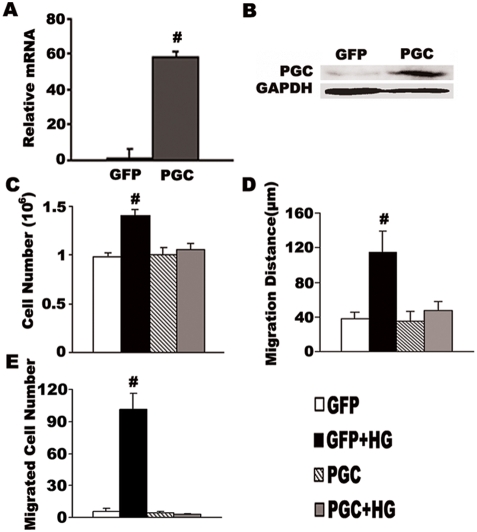
Overexpression of PGC-1α suppresses high glucose induced VSMC proliferation and migration.Cultured rat VSMCs in 5.5 mM glucose infected with adenovirus driving the expression of PGC-1α (PGC group) or GFP (GFP group) were either left untreated or incubated with 15 mM gluoose (HG) for 48 h. PGC-1α mRNA expression was determined by real-time RT-PCR (A), the values of PGC-1α/β-actin were normalized to that of control. 60 µg total proteins from VSMCs were assayed for Westernblot with PGC-1 antibody (B). Cell growth was determined by counting the number of cells (C). VSMC migration was determined by a standard wound healing assay (D) and by transwell analysis (E). The bars represent means±S.E.M (n = 6). **P<0.01, #P<0.001 compared with the GFP control group (GFP group).